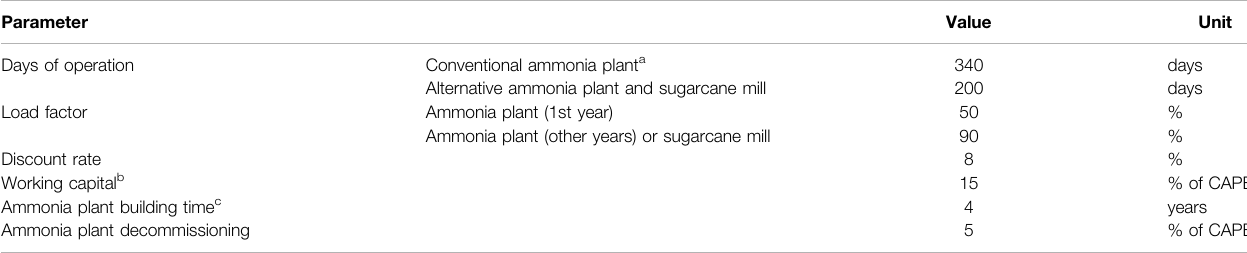
TABLE 2 | Main economic parameters adopted for the incremental fi nancial